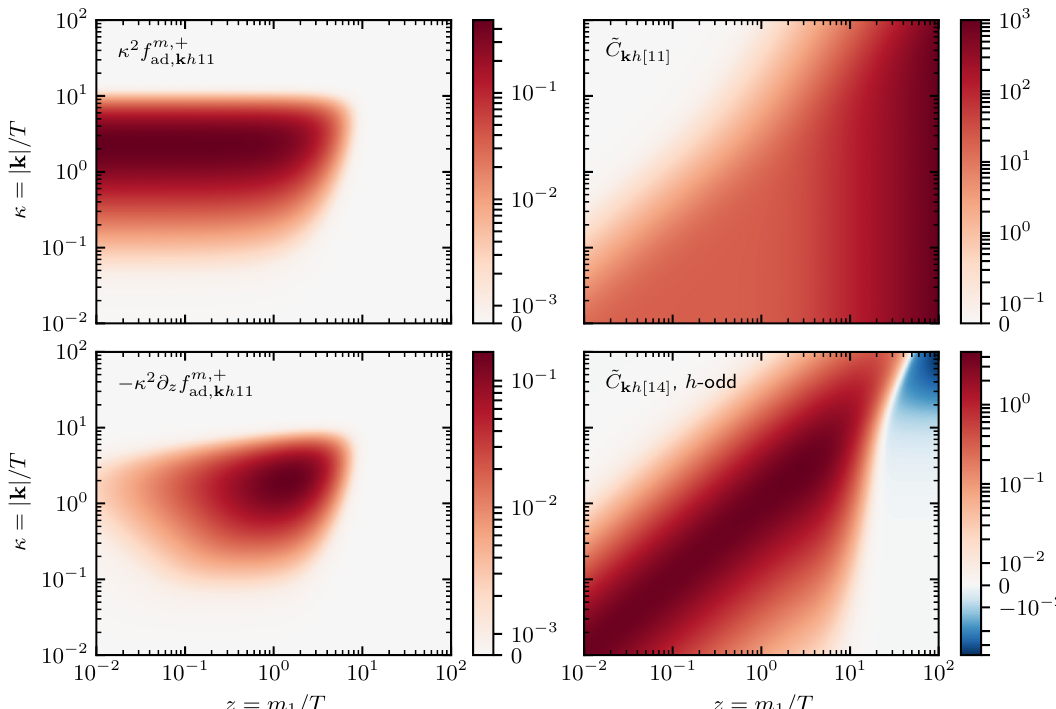
Figure 4. Shown are select intermediate functions of the Majorana neutrino equation (6.10). On the left: the adiabatic distribution function κ 2 f m, + − κ 2 ∂ z f m, + (bottom). On the right: the collision term coefficient functions ˜ C ad , k h 11 same for both helicities (top), and the helicity-odd combination ( ˜ C